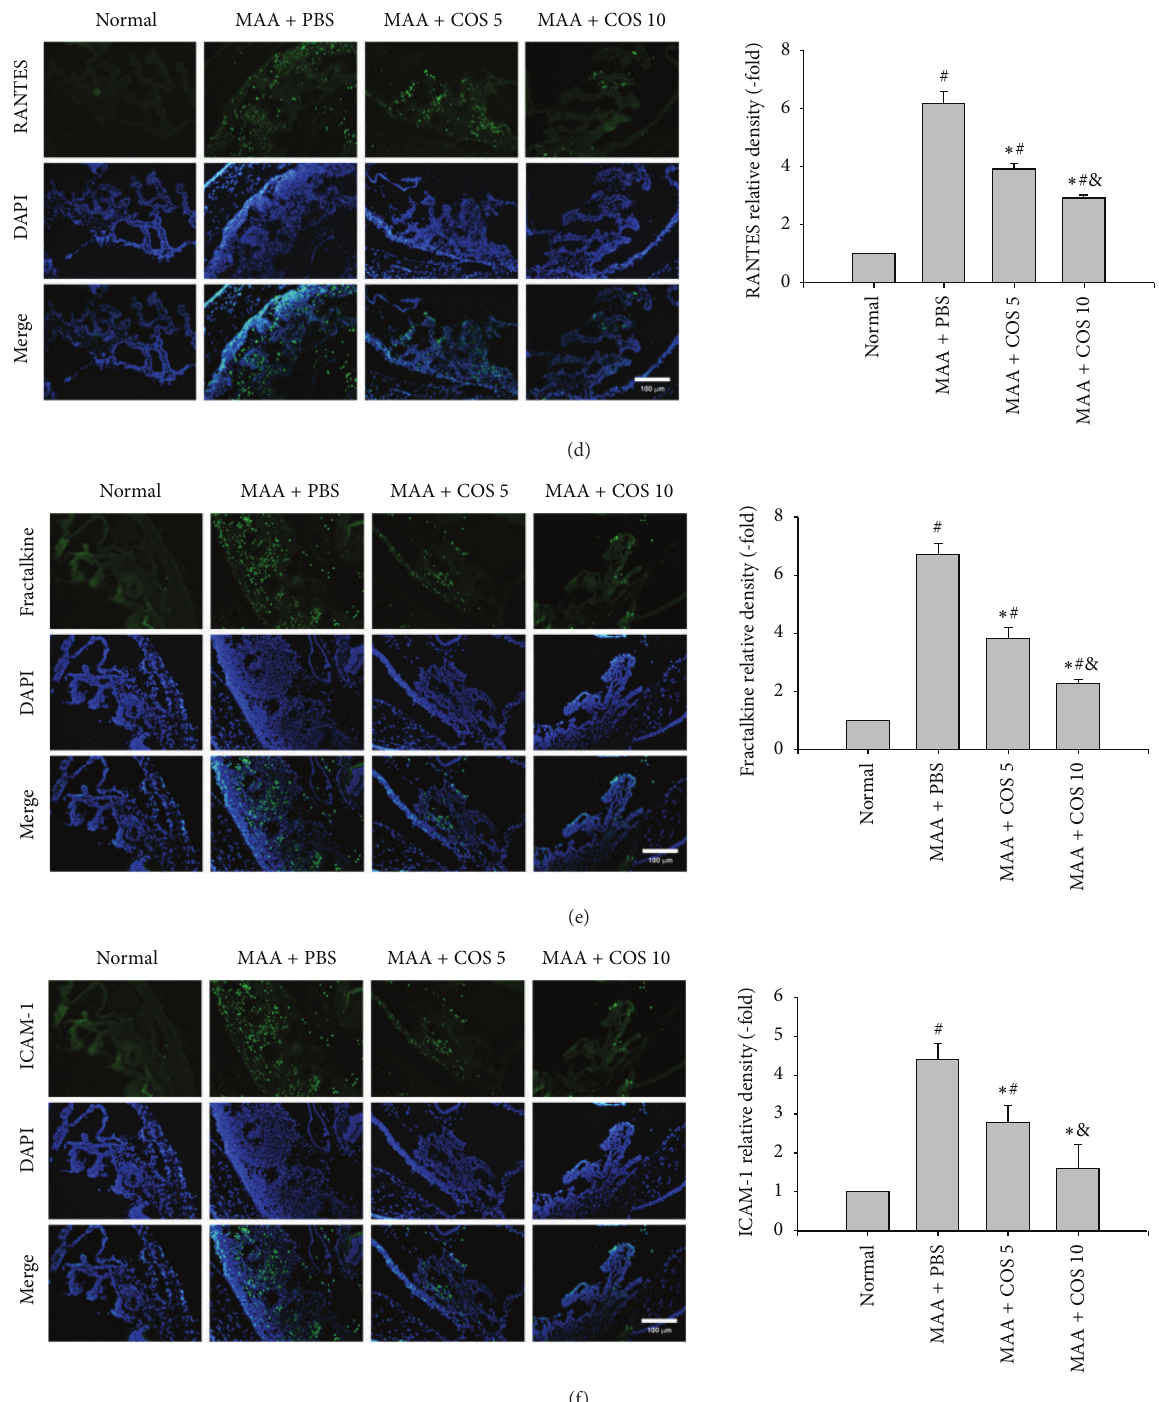
Figure 4: The evaluation of the expression levels of (a) TNF- 𝛼 , (b) iNOS, (c) MCP-1, (d) RANTES, (e) fractalkine, and (f) ICAM-1 in the ICB at day 14 using IHC. For quantitation of immunostaining, we first determined the immunostaining index, which could be measured and calculated from the following formula: ∑ [(immunostaining density − threshold) × area (pixels)]/total cell number. The relative density of immunostaining was defined as immunostaining index of PBS-treated, low-dose, or high-dose COS groups divided by immunostaining indexofnormalgroup.Treatmentwithlow-doseorhigh-doseCOSsignificantlydecreasedrelativedensityofTNF- 𝛼 ,iNOS,MCP-1,RANTES, fractalkine, and ICAM-1 in the ICB, when compared with the PBS-treated group. The effects of decreased inflammatory mediators in the ICB were more noticeable in the high-dose COS group than in the low-dose group. There was little variation between the eyes in the same group. Original magnification 100x ( ∗ 𝑃 < 0.05 compared with the PBS-treated group; # 𝑃 < 0.05 compared with the normal group; & 𝑃 < 0.05 compared with the low-dose group by Kruskal-Wallis 𝐻 test with post hoc Dunn test; 𝑛 = 3 for each